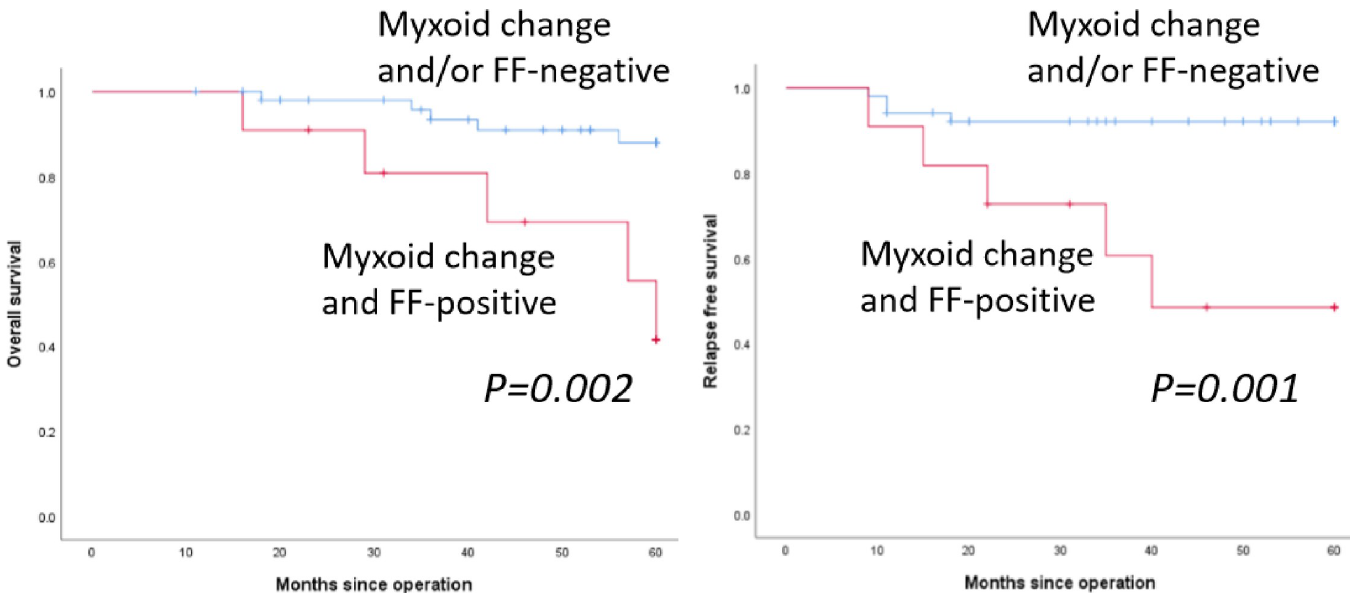
Fig 3. Survival for myxoid change- and fibrotic focus-positive patients vs. myxoid change- and/or fibrotic focus-negative patients. Overall survival (OS) (left) and relapse-free survival (RFS) (right) curves in myxoid change and FF-positive (red line) and myxoid change- and/or FF-negative (blue line)